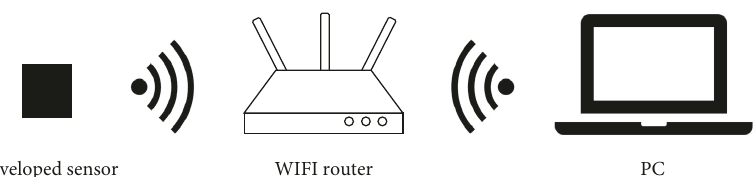
Figure 3: Simple schematic of the connection for data transmission over WIFI between a sensor and a